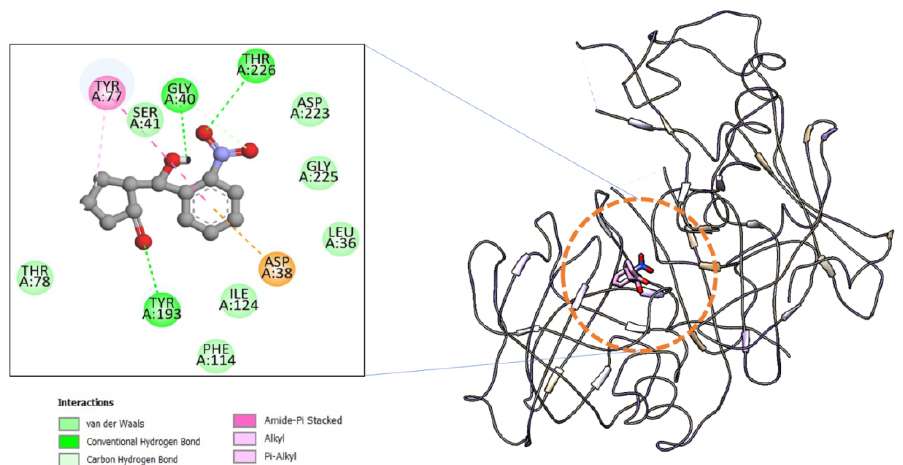
Figure 1. Binding conformation and chemical interactions of the compound at the active pocket of the beta ‐ secretase